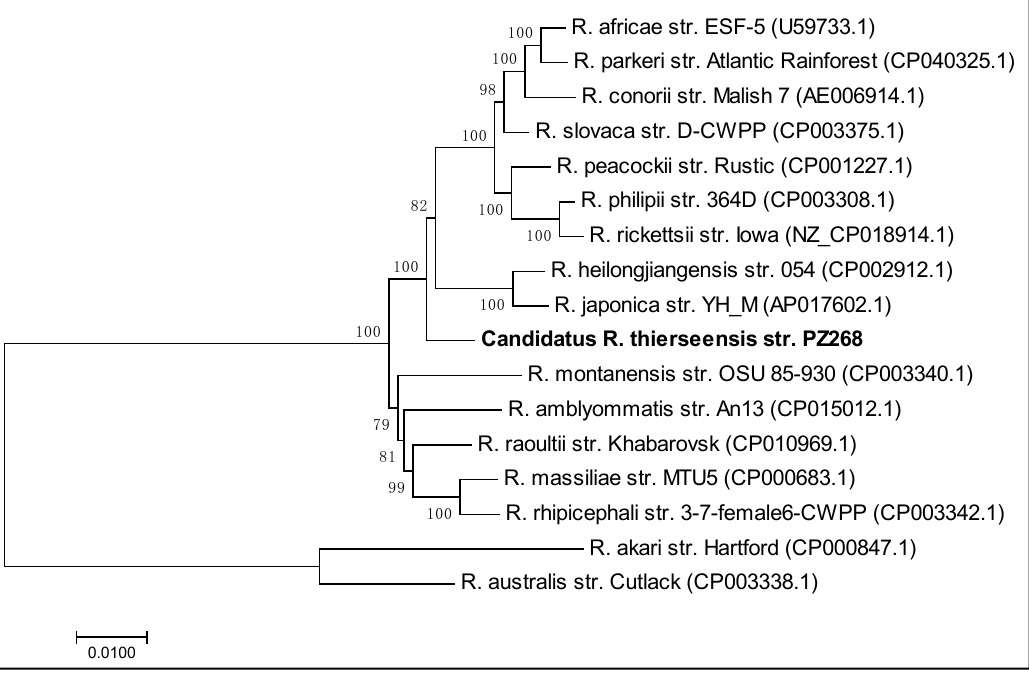
Figure 2. Maximum likelihood tree for multigenic phylogenetic analysis. Maximum likelihood tree built from 100 bootstrap replicates of the concatenated sequences of the gltA , ompA , ompB , sca4 and htrA genes, respectively. The Tamura three-parameter model was applied using a discrete Gamma distribution. A total of 17 Rickettsia spp. were included and the final dataset contained 9920 positions. Our Candidatus Rickettsia thierseensis strain is indicated by bold